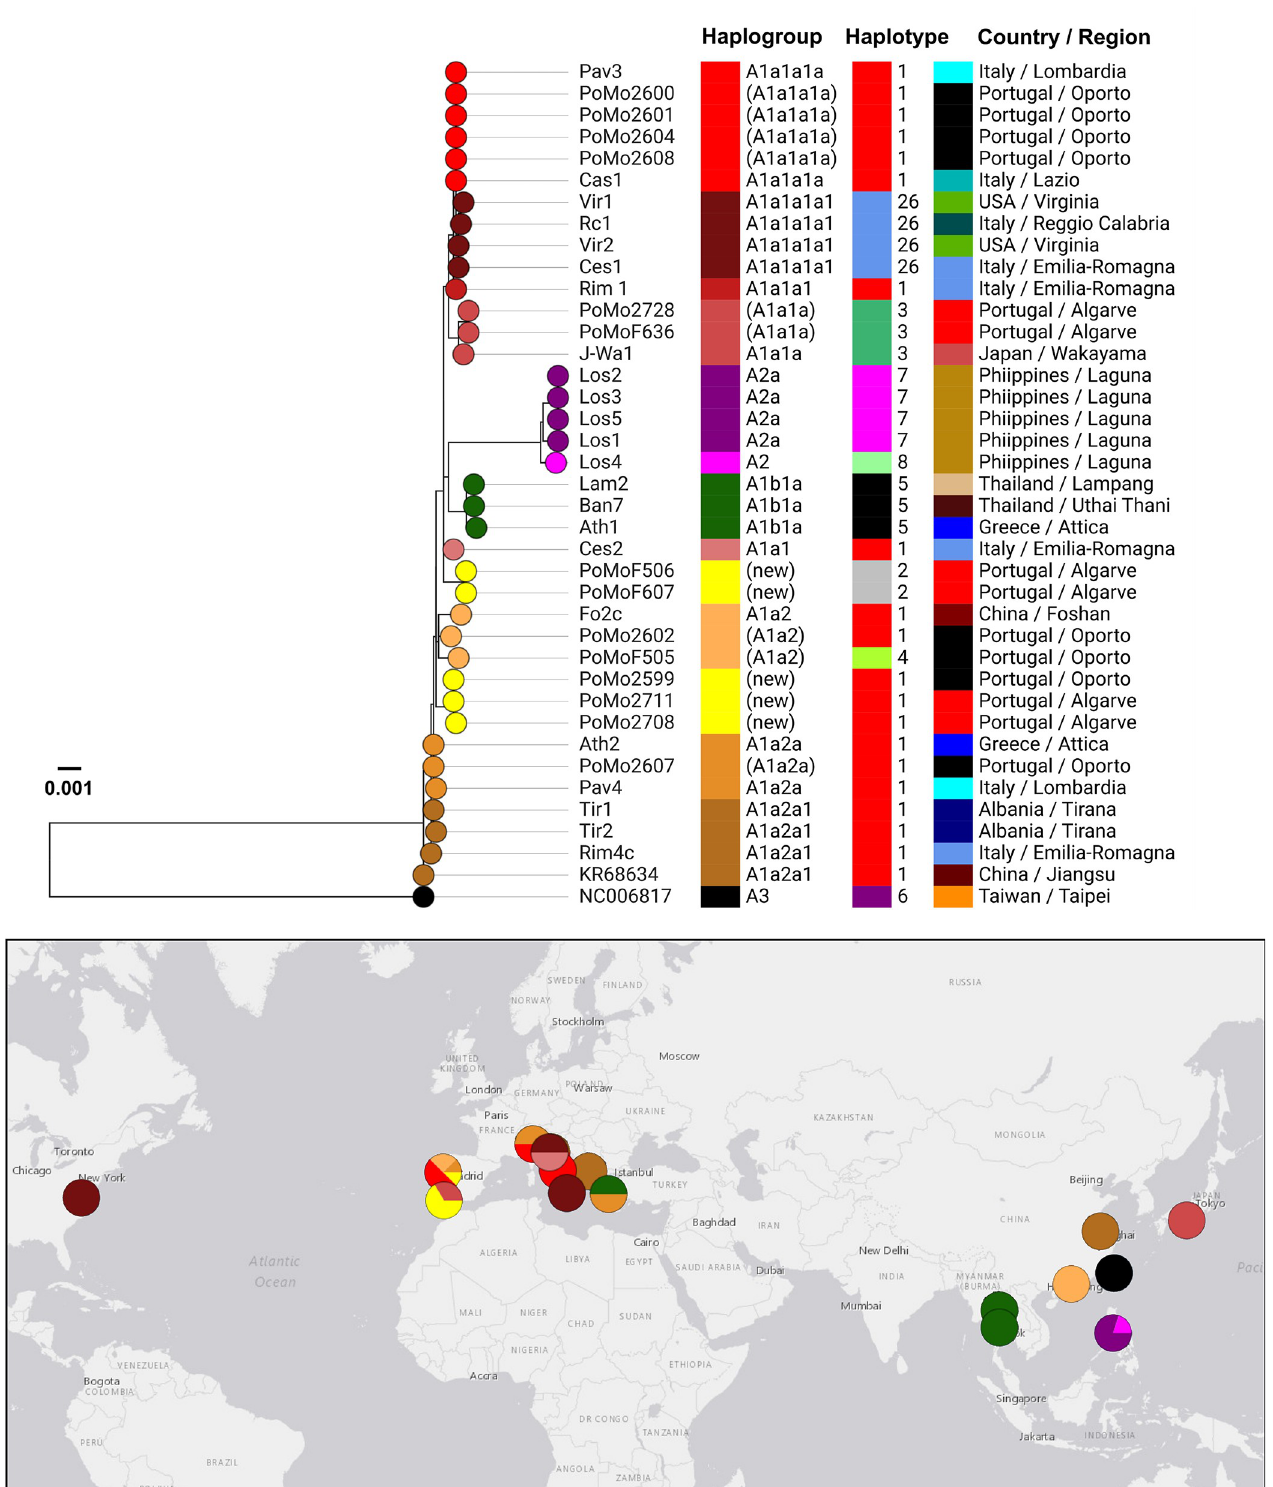
Fig 2. Mitogenome-based phylogeographic analysis of mosquitos detected in Portugal. The figure illustrates the integrative phylogenetic and geospatial analysis of 14 novel mitogenome sequences obtained from mosquito circulating in Portugal plus 25 sequences available in GenBank (S2 Table). The tree nodes are colored according with distinct mitogenome backgrounds (classified as haplogroup, according to Battaglia et al. [40] when possible). Colored blocks (from